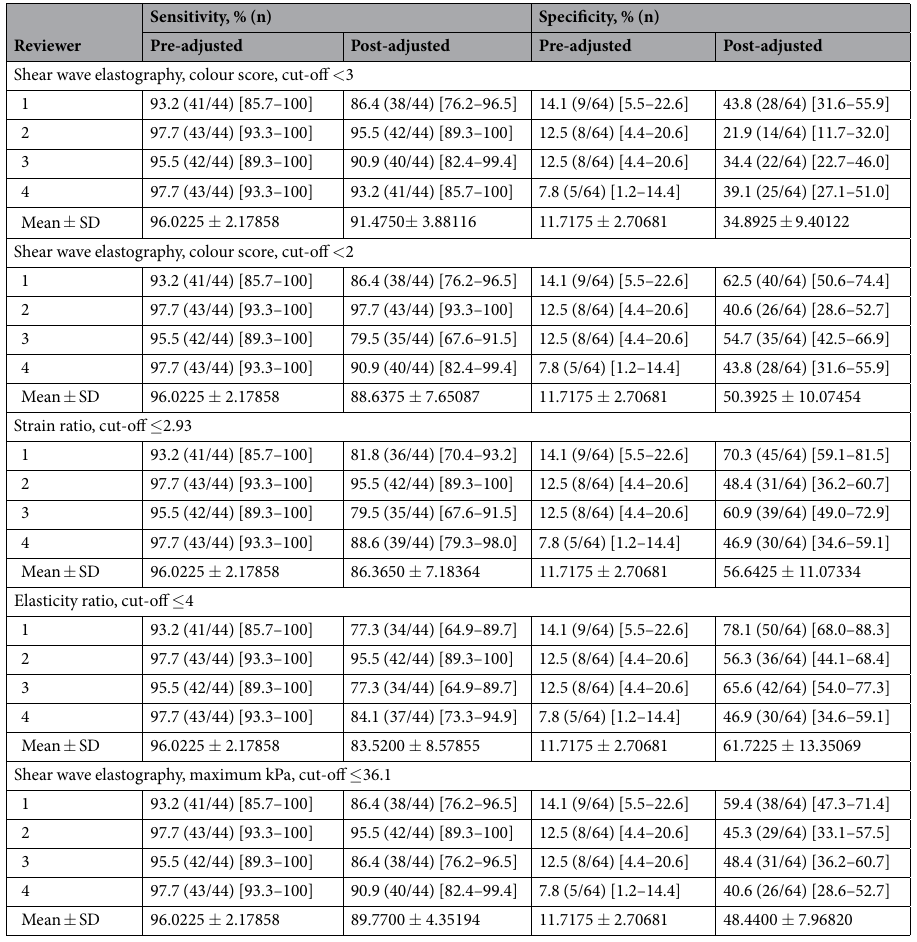
Table 4. Diagnostic performance of pre-adjusted and post-adjusted Breast Imaging Reporting and Data System (category 4a downgraded to category 3). SD, standard deviation; Except for Mean ± SD values, data are percentage (number of lesions/total) [95% confidence interval